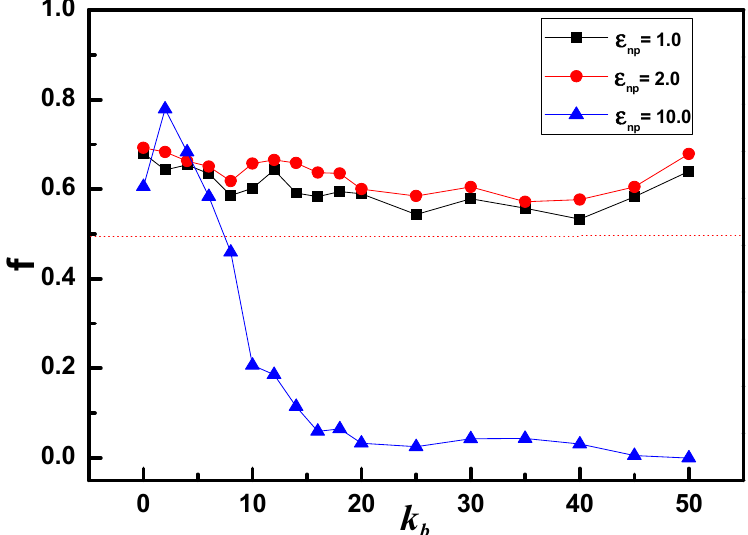
Figure 3. The fraction of ring chain to all chain in polymer-NP interfacial region, as a function of chain stiffness k b for three attractive interactions.